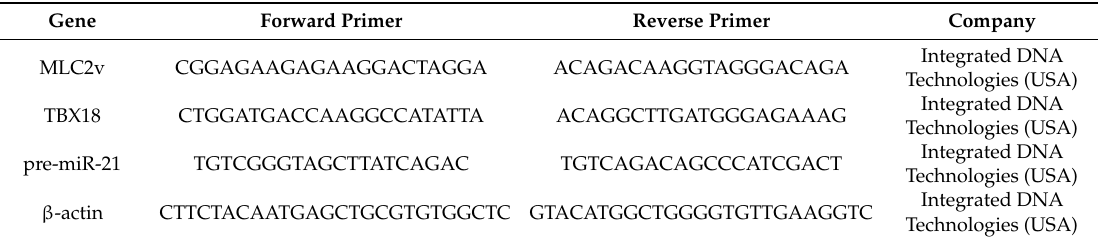
Table 1. Primer information used for qPCR